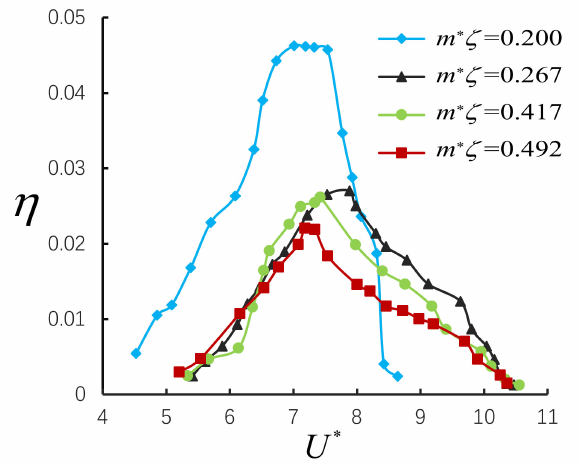
Figure 9. η with the change of U ∗ of experiment II.